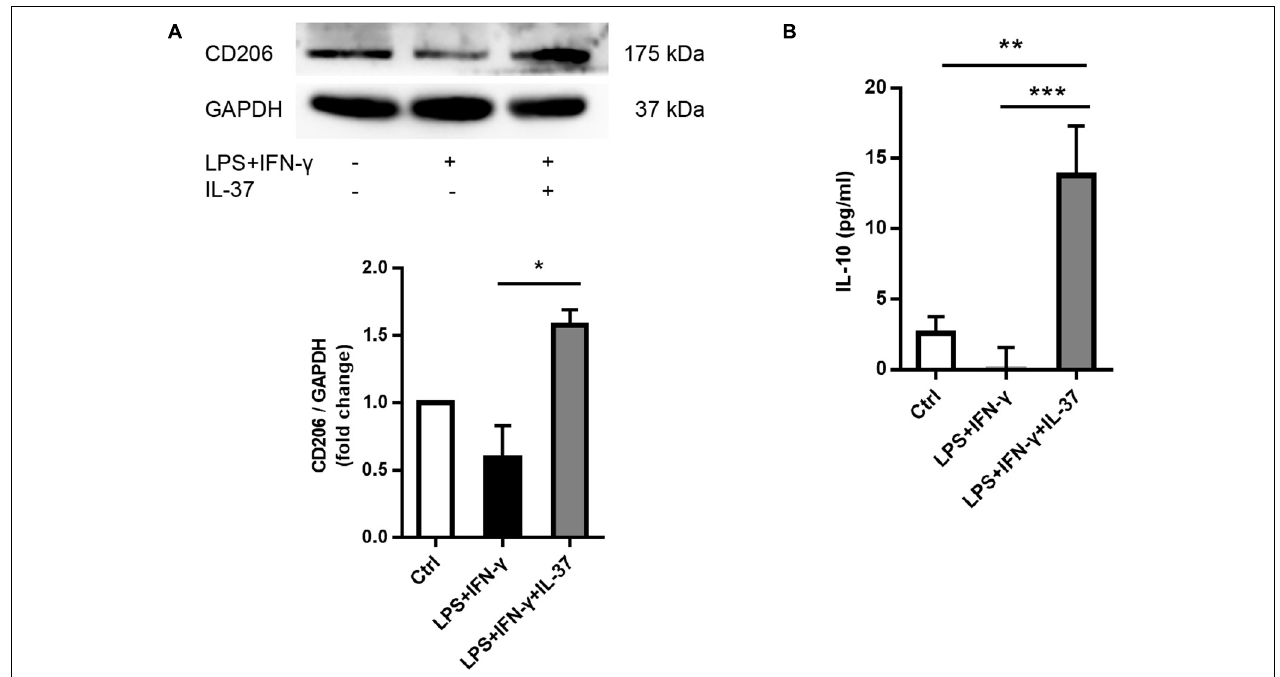
FIGURE 3 | IL-37 promotes the expression of M2 macrophage markers. (A) Representative immunoblots and densitometric data show that CD206 expression increases after pre-treating PMA-treated THP-1 cells with recombinant human IL-37 (0.1 ng/ml) prior to stimulating with LPS (100 ng/ml) and IFN- γ (20 ng/ml); n = 3, * P < 0.05. (B) The ELISA data show that IL-37 up-regulates IL-10 secretion; n = 4, ** P < 0.01, *** P < 0.001.